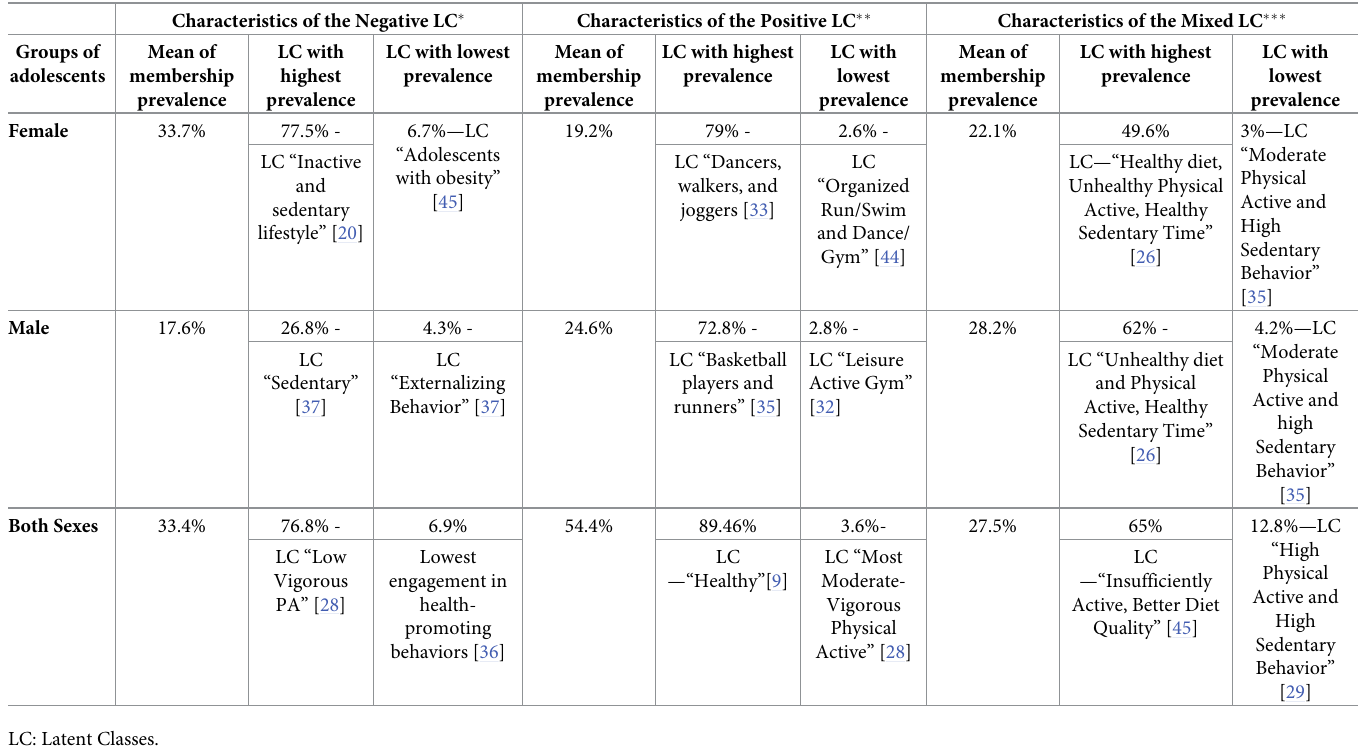
Table 3. Membership prevalence and main characteristics of the latent classes (LC) in female and male adolescents. Characteristics of the Negative LC